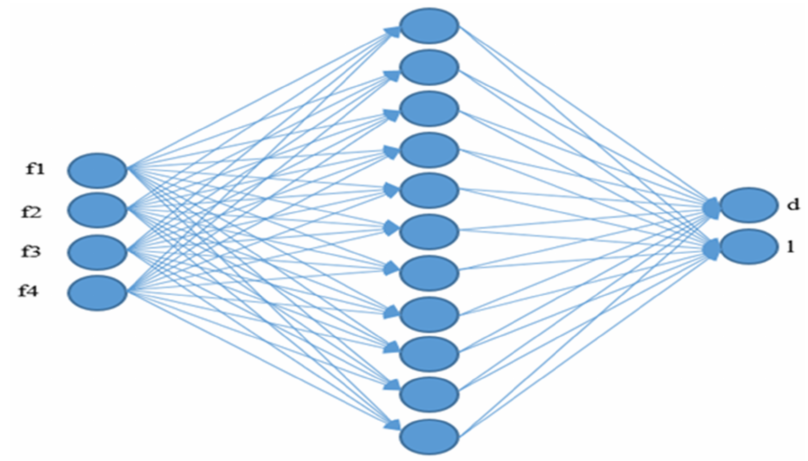
Figure 14. Diagram of the obtained optimal ANN architecture.